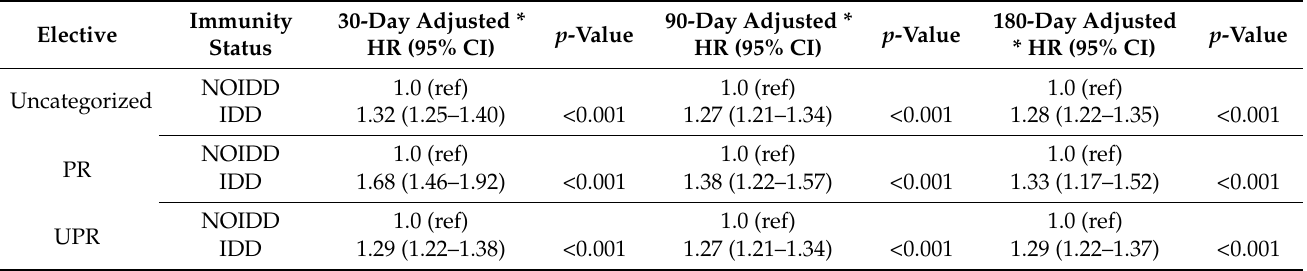
Table 2. Adjusted hazard ratio of the association of IDDs with readmission stratified by 30 days, 90 days and 180